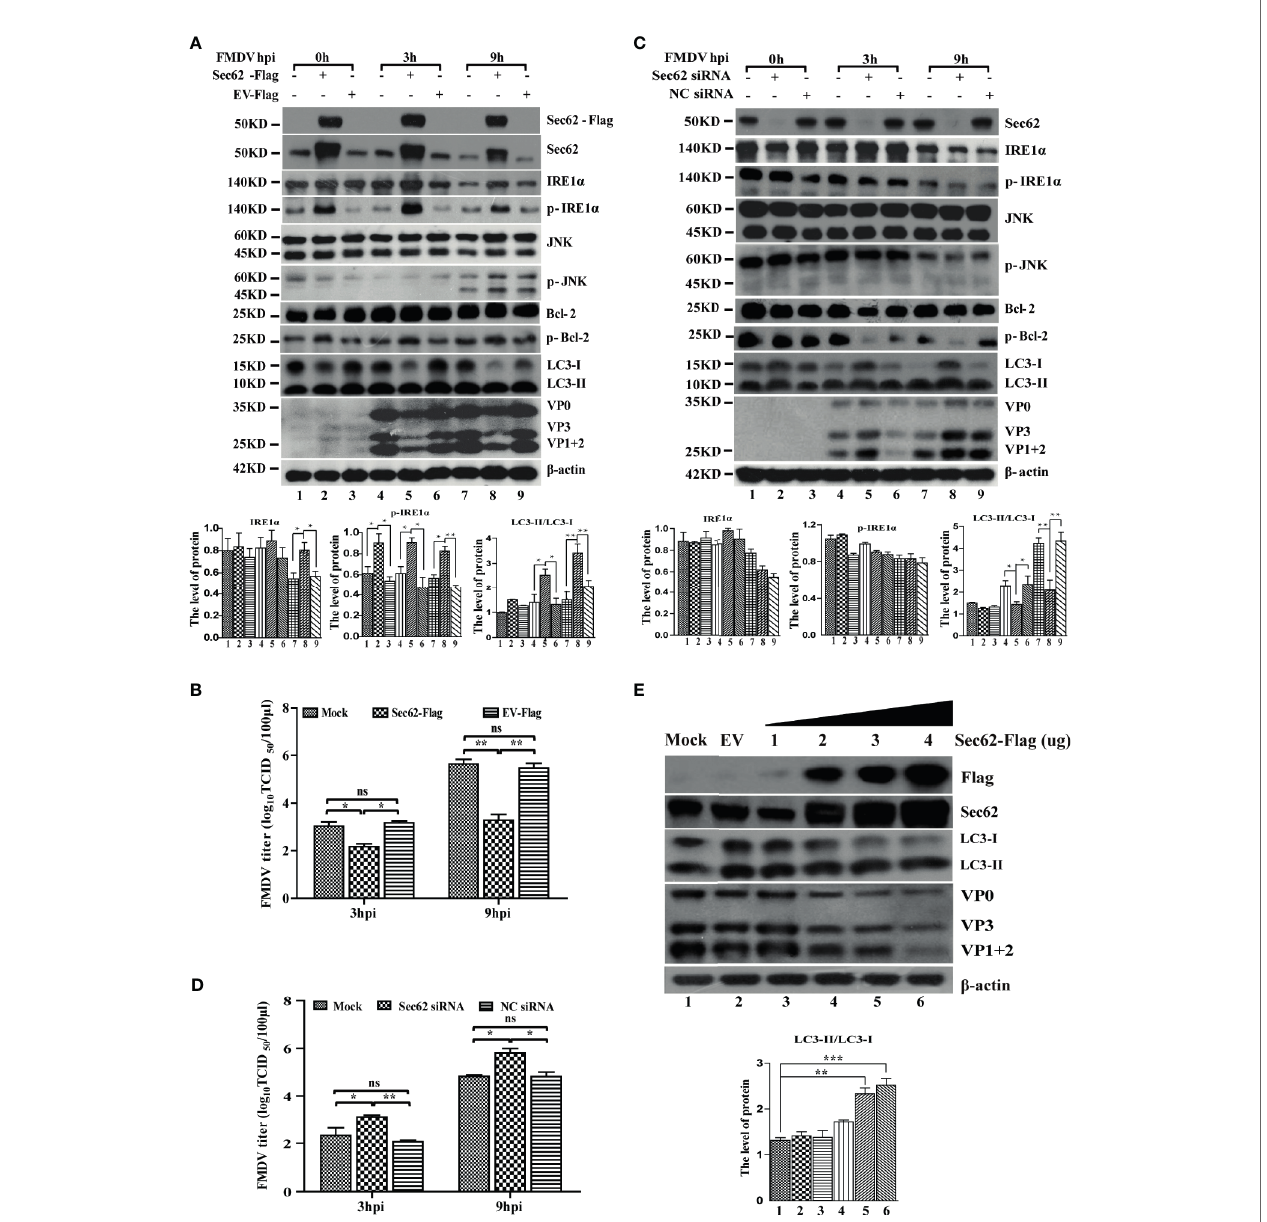
FIGURE 5 | Sec62 promotes autophagy through promoting the phosphorylation of IRE1 a . (A , C) PK-15 cells were transfected with cognate Flag-Sec62 plasmid and EV for 24 h or transfected with NC siRNA and Sec62 siRNA for 36 h, followed by FMDV infection. Cell lysates were harvested at 0, 3, and 9 hpi. The downstream effectors of the IRE1 a -JNK pathway signaling were analyzed by Western blotting. The levels of related proteins were normalized to b -actin; data were expressed as means ± SD of three experiments. Every treatment group compared with control groups, respectively, * p < 0.05, ** p < 0.01. (B , D) The viral titers were determined by TCID 50 in Sec62-overexpressed/knocked down PK-15 cells. Data are analyzed as mean ± SD; * p < 0.05, ** p < 0.01. (E) PK-15 cells were transfected with the empty vector expressing pCMV-Flag (EV) and increasing Flag-Sec62 expression vector (wedge) concentrations for 24 h. The cell lysates were analyzed by Western blotting. The levels of related proteins were normalized to b -actin; data were expressed as means ± SD of three experiments. Every treatment group compared with control groups, respectively; * p < 0.05, ** p < 0.01, *** p < 0.001. ns, no signi fi